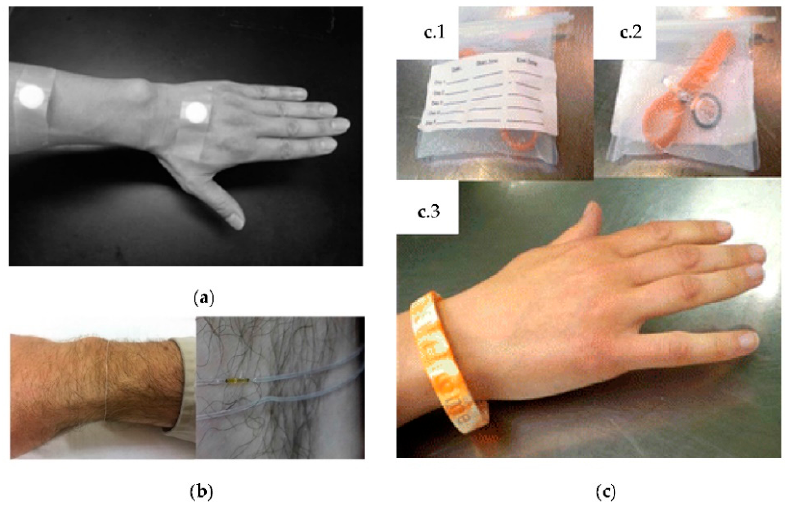
Figure 5. ( a ) Sampling of volatile chemicals on the forearm and back of the hand before and after cigarette smoking or exposure to second hand smoke (SHS). ( b ) Wrist (left) and ankle (right) sampling using a PDMS loop passive sampling device. ( c ) c.1–2 bags used for transport that were attached to track participant ID and exposure time in the occupational deployments; c.3 single wristband deployment. Reproduced from [75,77,78], with permission from Elsevier and ACS Publishing, 2019.